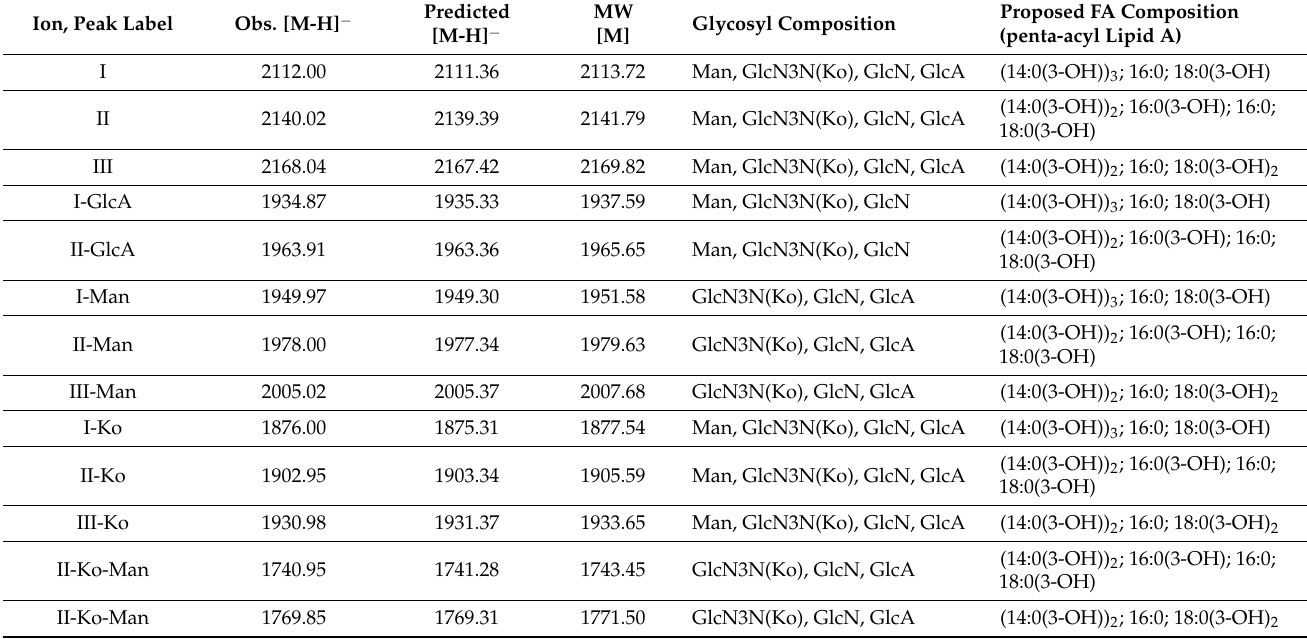
Table 3. Major [M-H] − molecular ions observed in MALDI-TOF MS analysis of G. bethesdensis Ko–lipid A and proposed composition (corresponding MALDI-TOF MS spectrum in Figure